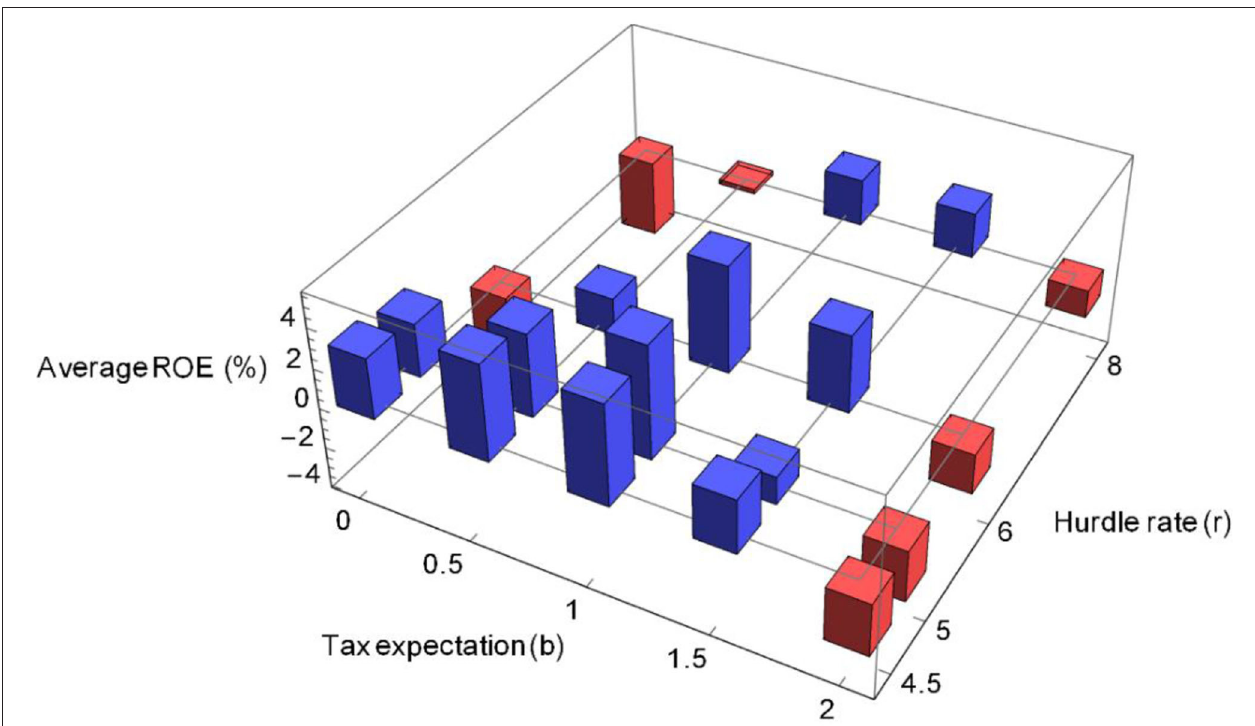
FIGURE 7 | The average ROE over a 10-year period for the 20 agents during the expansion phase from year 30 to 40. Positive and negative values are depicted by blue and red, respectively. Companies with more accurate expectations on tax changes perform better during this period. In the base case, we use f = 30% and i = 400M e . f is the fraction of an investment financed by a company’s own capital and i is the initial capital in a company’s bank